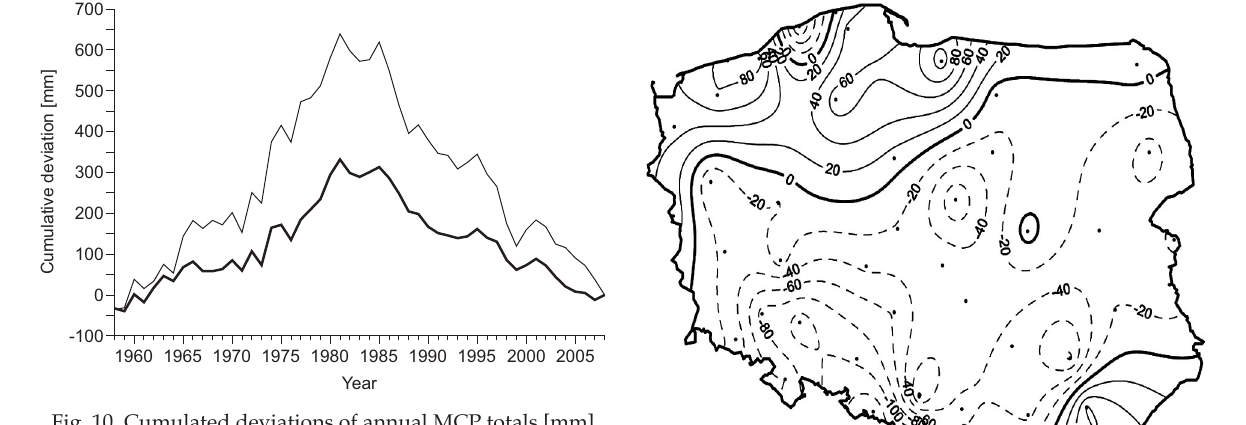
Fig. 10. Cumulated deviations of annual MCP totals [mm] from the long-term mean for the period 1958–2008. Bold line – mean deviations in the area of Poland, thin line – mean deviations in the mountain and foreland areas